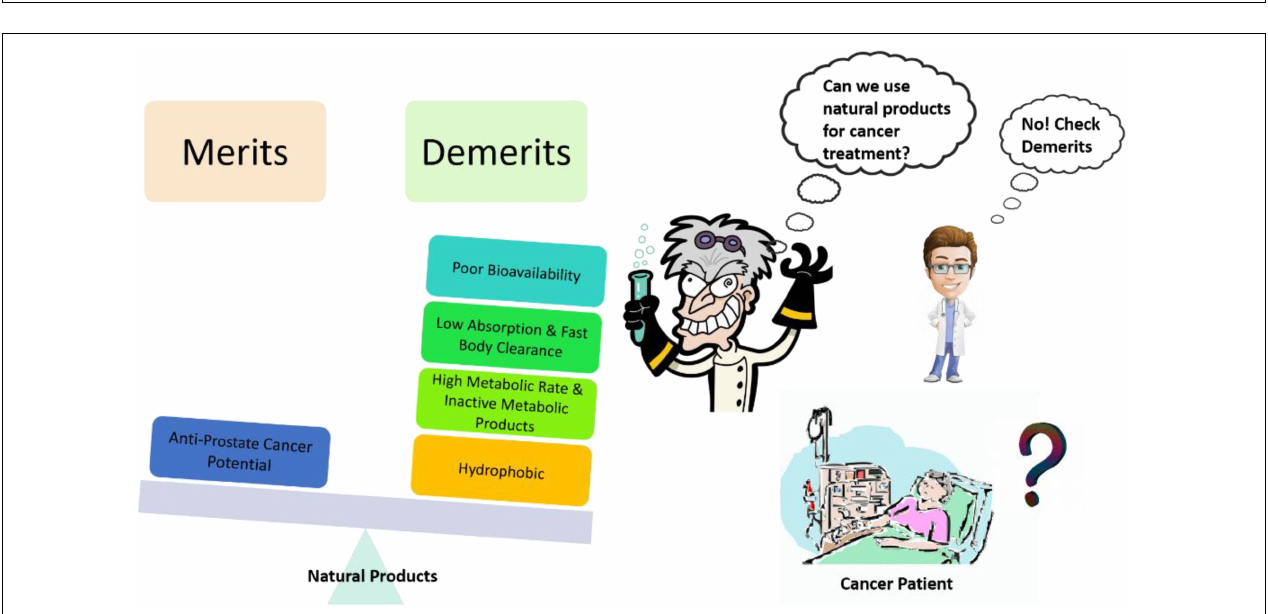
FIGURE 3 | Common problems associated with natural products as an anti-prostate cancer agent and creating hurdles in their translational potential.